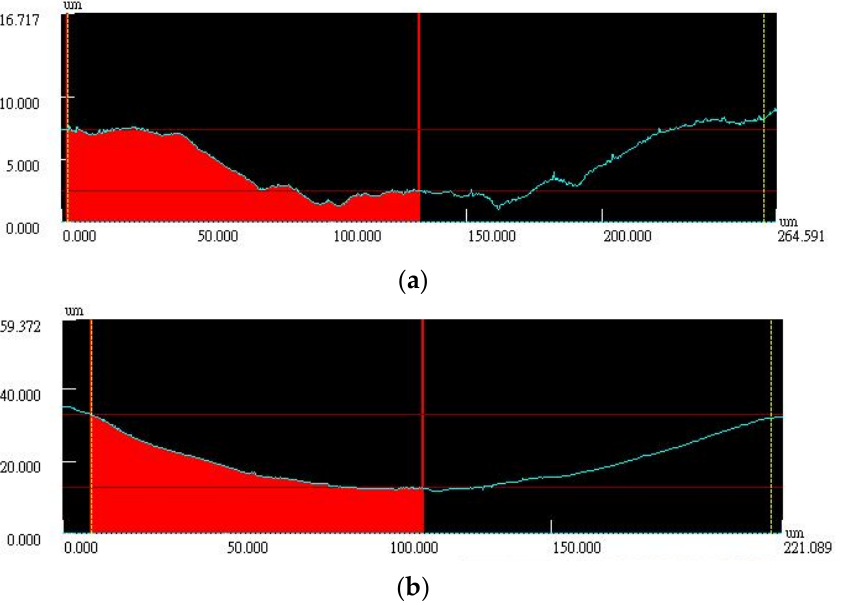
Figure 10. Cavity bottom profile results from ( a ) DI-water ECM, ( b ) hybrid ECM polishing with alumina abrasives.